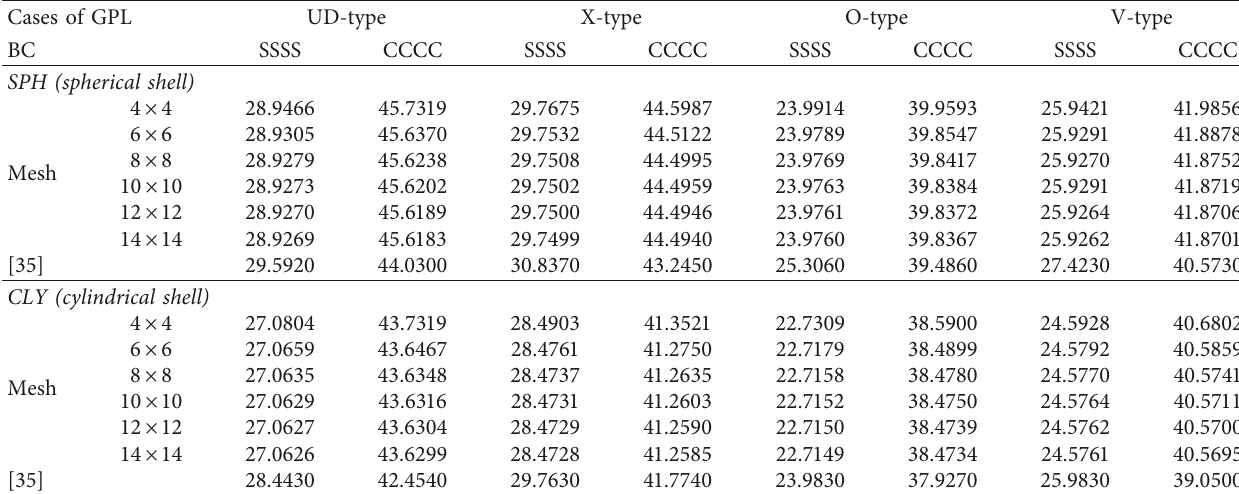
Table 3: The first nondimensional fundamental frequencies with different meshes.